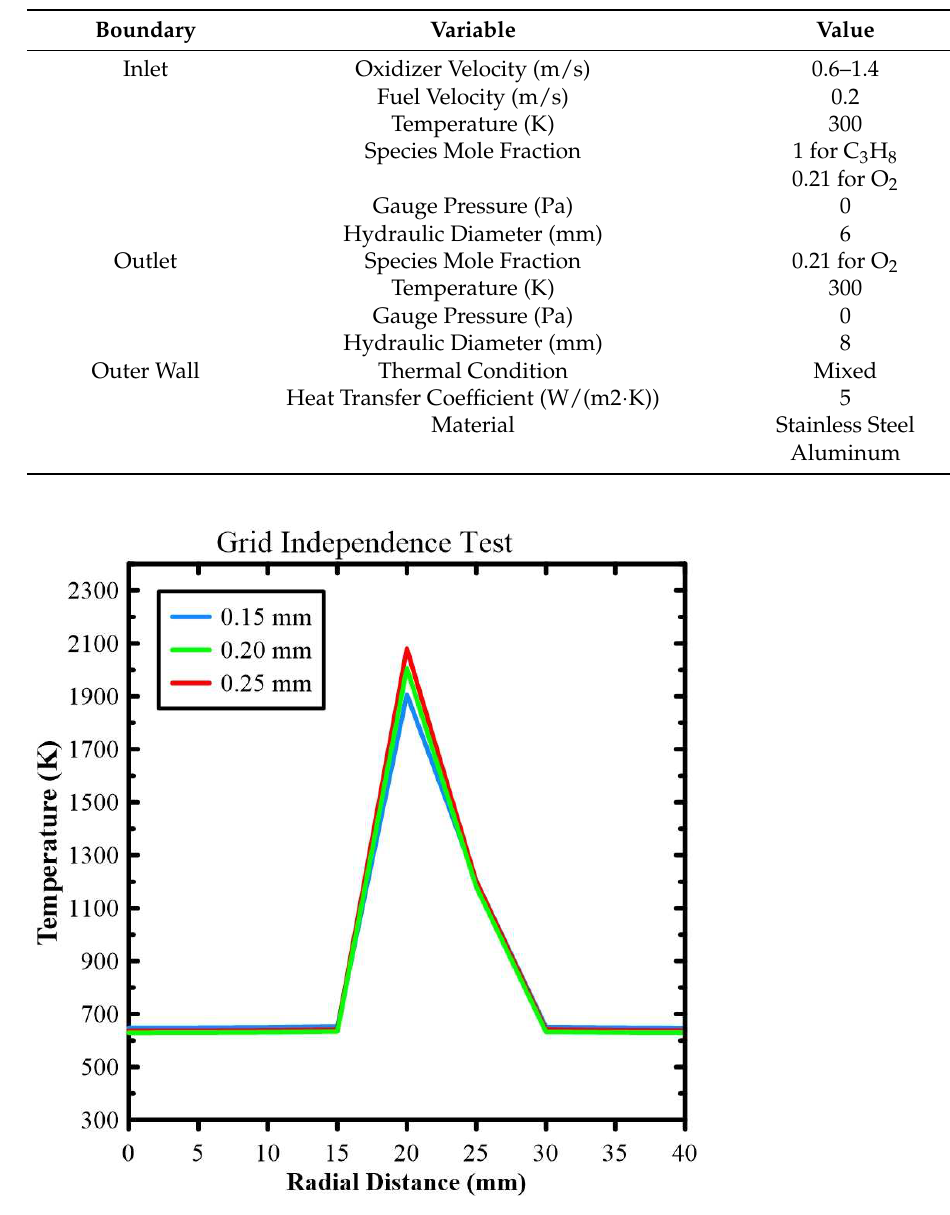
Figure 6. Grid independence test .